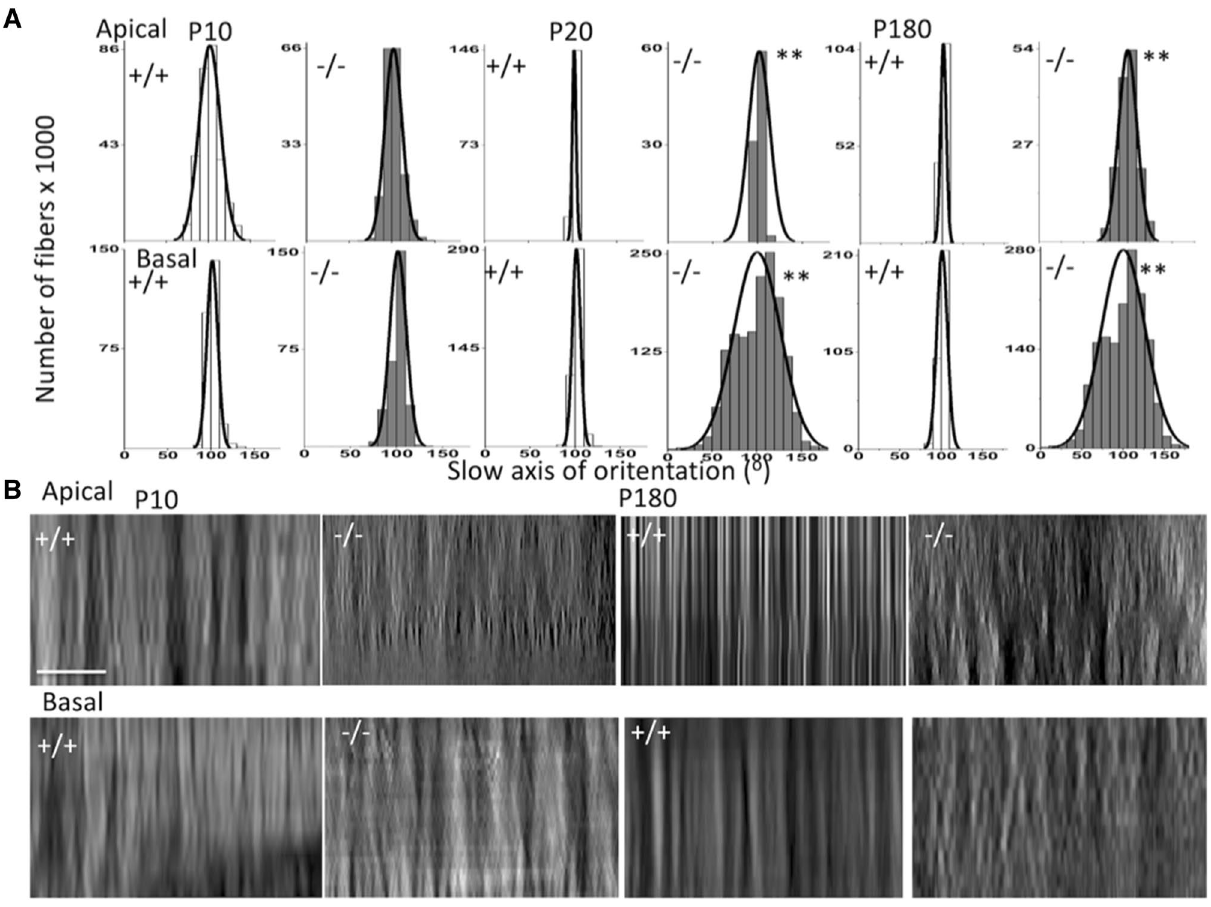
Figure 5. BM fibers become more misaligned and twisted in Emilin2 −/− mice to compared to wild type BM. ( A ) Histograms of BM fiber orientation as function of developmental stage (P10, P20 to P180) for measurements in the apical (top row) and basal (bottom row) cochlea regions. Fiber orientations were assigned to 10° bins. The mean orientation in each preparation was normalized (to ~ 101°) and the resultant histograms were fitted with normal distribution curves. Table 2 lists SD from the mean. Groups, three mice (six cochleae); differences in SD, ** p < 0.0001, F test statistics. Fiber orientations for the apical turn were measured from optical Sects. (0.5 μm apart in 8 optical sections). Measurement numbers for each developmental age: P10 n = 90,001; P10 -/- n = 53,920 ; P20 n = 163,805 ; P20 -/- n = 164,805;P 180 n = 166,203; P180 -/- n = 167,203 ; using BM samples from six cochleae (3 mice) per age group. Fiber orientations measured for the basal turn(bottom row) were measured from optical Sects. (0.5 μm apart in 20 optical sections). Measurement numbers for each developmental age: P10 n = 283,742; P10 -/- n = 27,246; P20 n = 145,339; P20 -/- n = 151,419; P180 n = 147,231, P180 -/- n = 149,250 using BM samples from six cochleae (3 mice) per age group. ( B ) Birefringent images constructed from optical stacks of transverse sections taken through the pectinate zone of the BM have less homogeneous and more braded appearance with increasing stages of development in emilin -/- compared to emilin +/+ BM. Transversal (plane pl in Fig. 3E) filament array images reconstructed from stacks of pectinate zone optical sections for P10, P20 and P60 emilin +/+ and emilin −/− cochleae (0.5 μm apart; 8 apical and 18 middle optical sections; total thicknesses are 4 and 9 μm, respectively). Scale bar 5 μm.